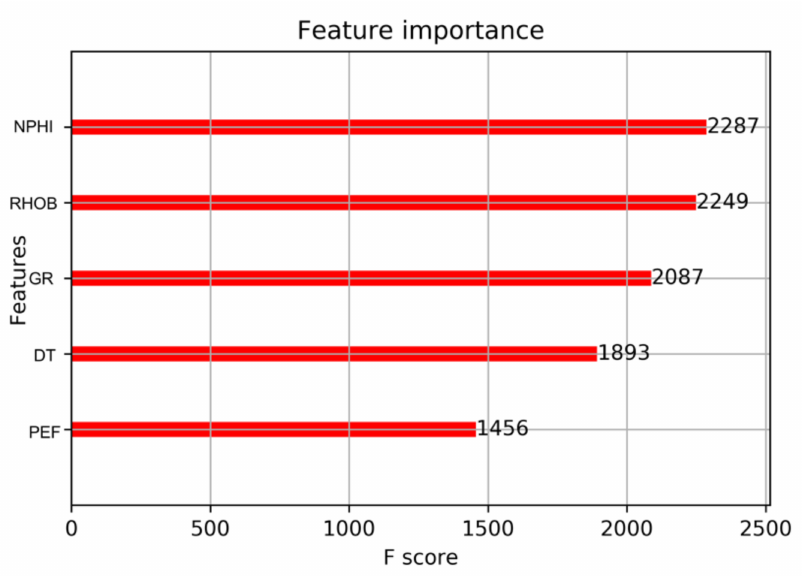
Figure 12. The estimated score for potential input parameters. It can be seen that PEF has the lowest importance compared to all other well logs.